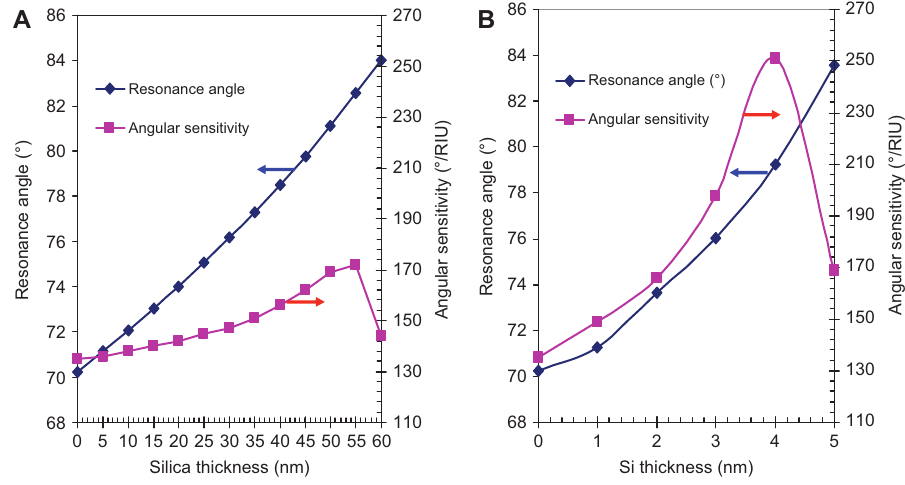
Figure 6 Change of angular sensitivity (pink) and position of resonance angle (blue) with different (A) silica; and (B) silicon top layers on gold thin fi lms. Parameters used for calculations: n = 0–5 d silicon